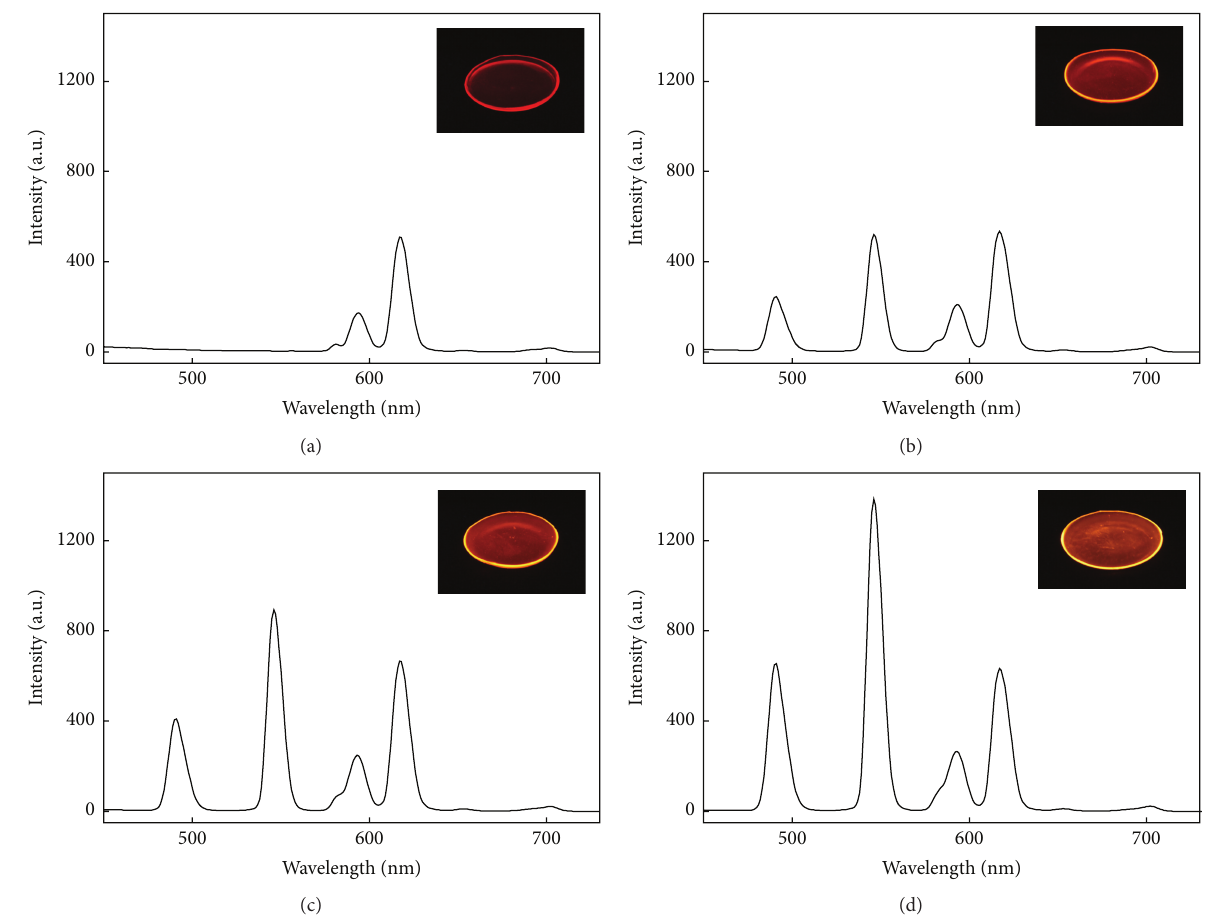
Figure 5: Emission spectra of (a) 0.2wt% EBA, (b) 0.4 wt% TBA-0.2 wt% EBA, (c) 0.8 wt% TBA-0.2wt% EBA, and (d) 1.4wt% TBA-0.2 wt% EBA incorporated PMMA under 254 nm UV radiation. Inserted photos: fluorescence from corresponding samples.